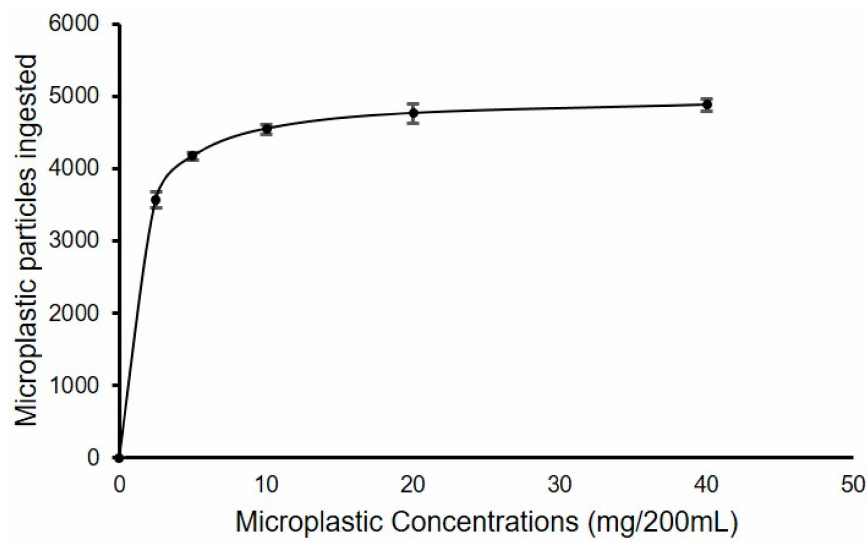
Figure 3. MP particle ingestion rate by P. acuta at six concentrations of MP (each data point represents mean and standard errors of 10 replicates).